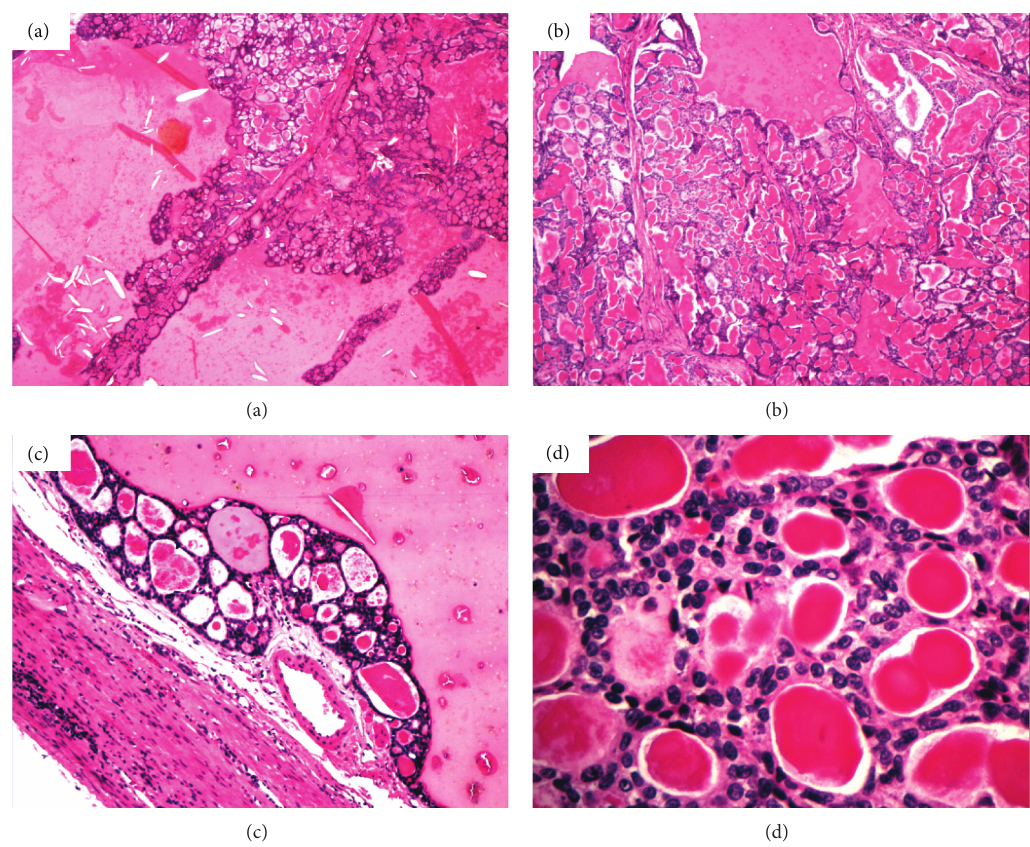
Figure 4: Histological appearance of the tumour. (a) × 2 Follicular areas with fibrous septa and lakes demonstrating clefting. (b) × 4 Fibrous septa and variably sized follicles. (c) × 10 Compressed rim of parenchyma with follicles showing variable appearance of colloid-like material at the edge of a colloid-like lake. (d) × 40 Nuclei demonstrating a fine chromatin pattern with inconspicuous nucleoli.